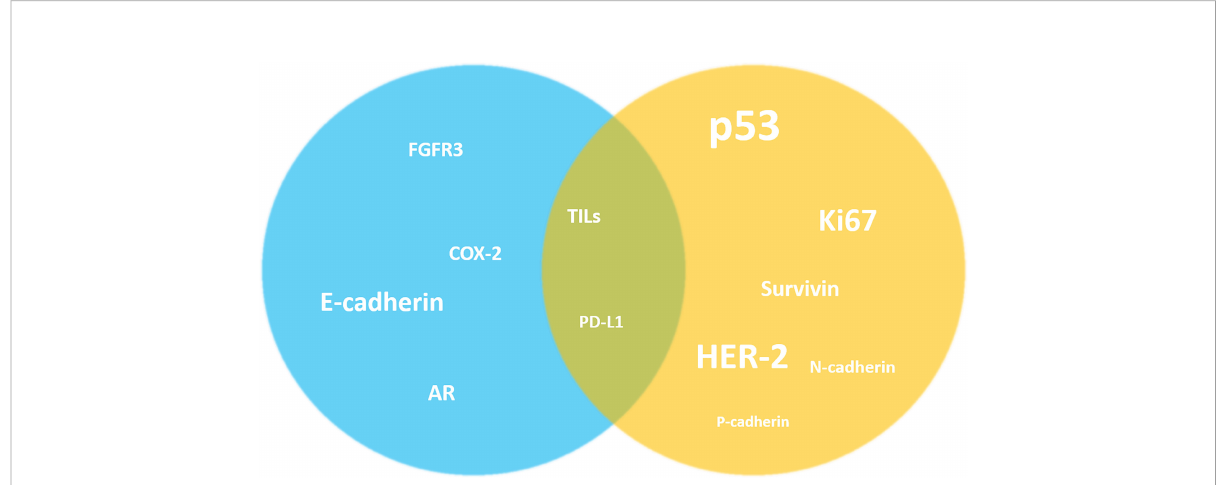
FIGURE 1 Overall estimation of the possible impact on clinical outcome of the main prognostic biomarkers expression or overexpression in NMIBC. Despite the highlighted con fl icting results, it is possible to identify a tendency of the markers to be reported as predictors of better (blue) or worse (yellow) outcome in the literature. For other markers this simpli fi cation is not possible (in the middle).The size of the markers graphically re fl ects the number of studies investigating their prognostic role in NMIBC. AR, androgen receptor; COX-2, Cyclooxygenase-2; FGFR3, fi broblast growth factor receptor 3; HER-2, human epidermal growth factor receptor 2; TILs, tumor-in fi ltrating